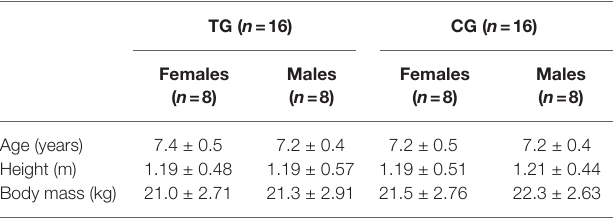
TABLE 1 | Demographic characteristics of the participants (Mean ±